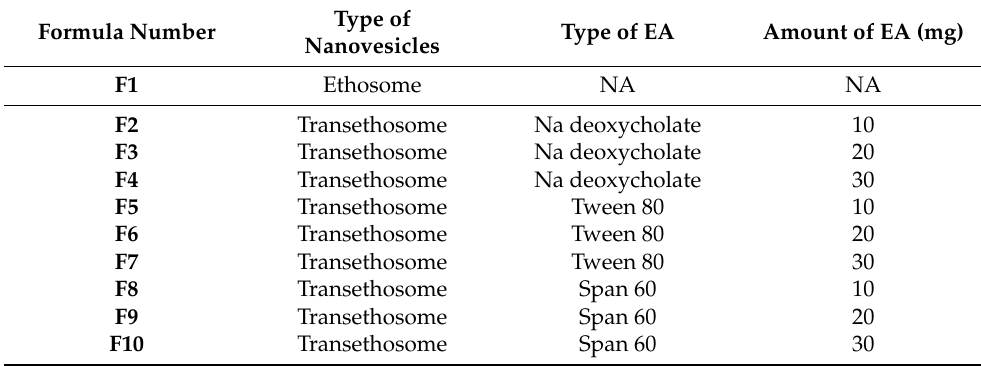
Table 1. Composition of the prepared CXB-ES and